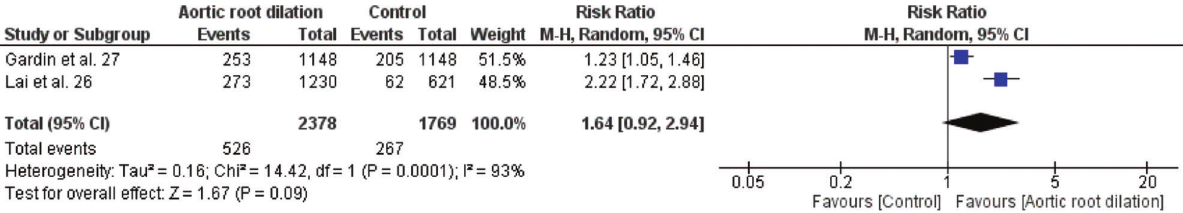
Figure 3.3 - The Risk Ratio and 95% confidence interval (CI) in the all-cause mortality, for aortic root dilation group versus the Control group.